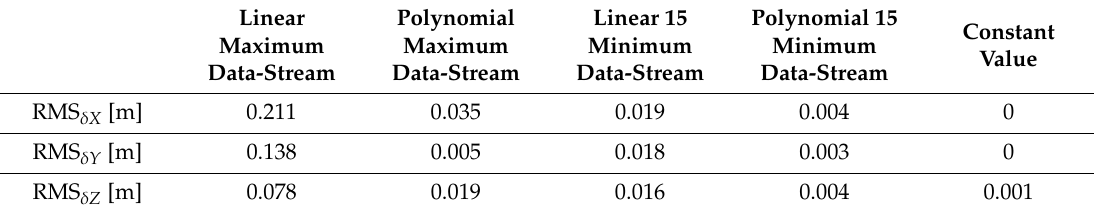
Table 4. The RMS values of the time series of geocentric corrections between each IODE change value (GPS